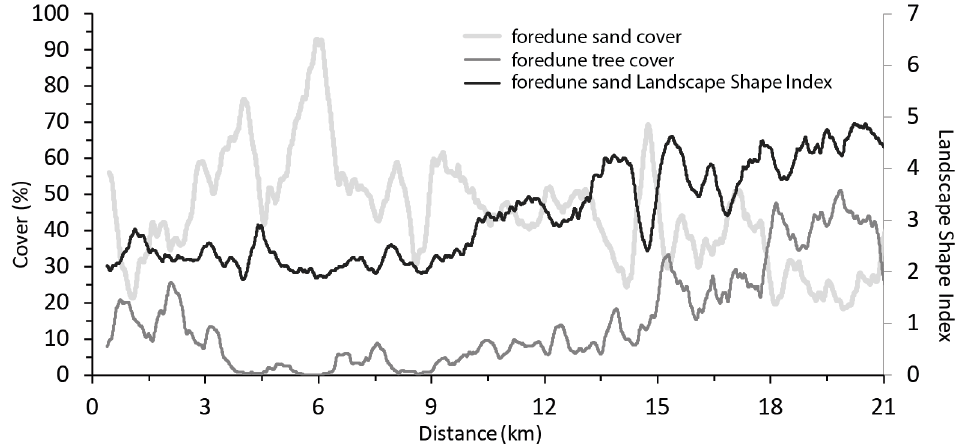
Figure 12. The foredune sand cover (light grey line) has higher values in the northern part of the stretch, while the landscape shape index (black line) has higher values in the south. A major contribution to these behaviors is due to the growing cover percentage of trees (dark grey line) moving from north to south. Values are reported as moving averages of data points (average of 100 data points interval).